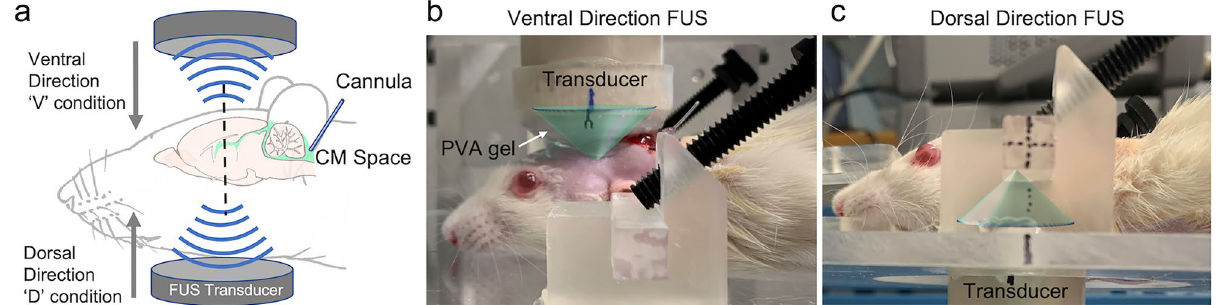
Figure 3. Schematics of the sonication setup for enhancing CSF solute movement in rat brain. ( a ) Illustration of the tFUS setup and the site of the CSF tracer injection. The transducer was mounted to a 2-axis mechanical stage and the animal was positioned over the stereotactic frame that moves vertically. ( b ) Sonication was delivered in the ventral direction through coupling PVA hydrogel and ( c ) to the dorsal direction below the neck. The green cones depict the acoustic